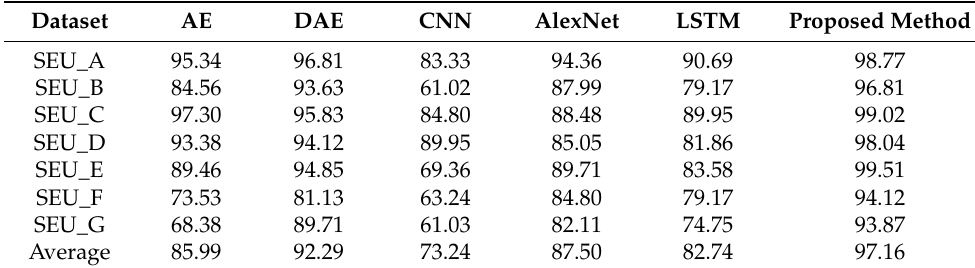
Table 4. Accuracy (%) of different algorithms for SEU dataset.